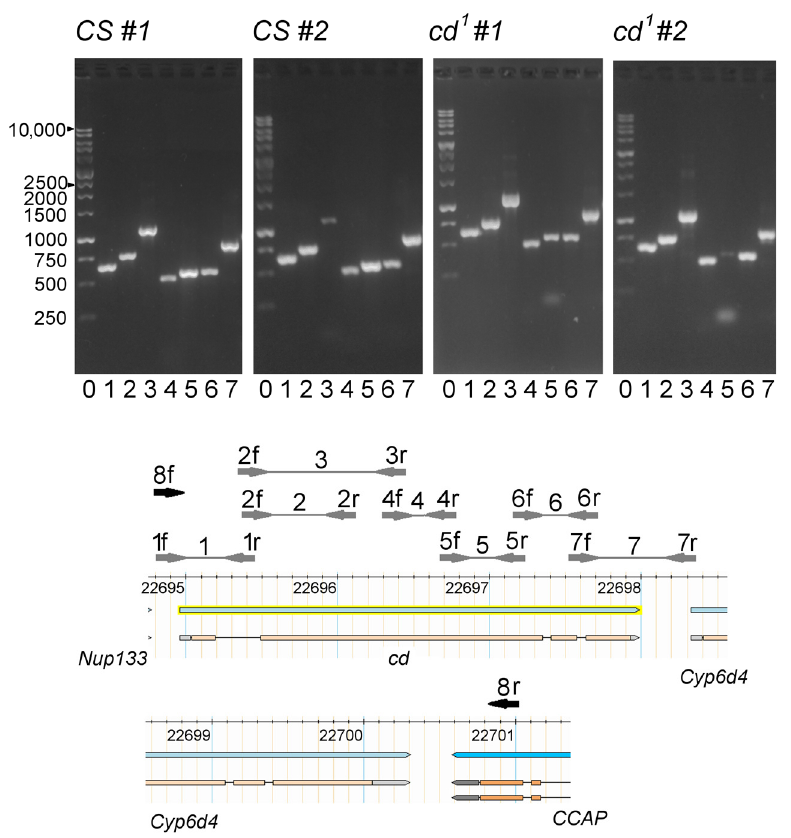
Figure 2. PCR mapping of the cd gene in CS and cd 1 mutant. 0: 1 kb ladder. 1–7: the primer pairs (f—forward, r—reverse). Positions on the X chromosome are shown in kb (FlyBase data). 8fr—the amplicon III (see the text).